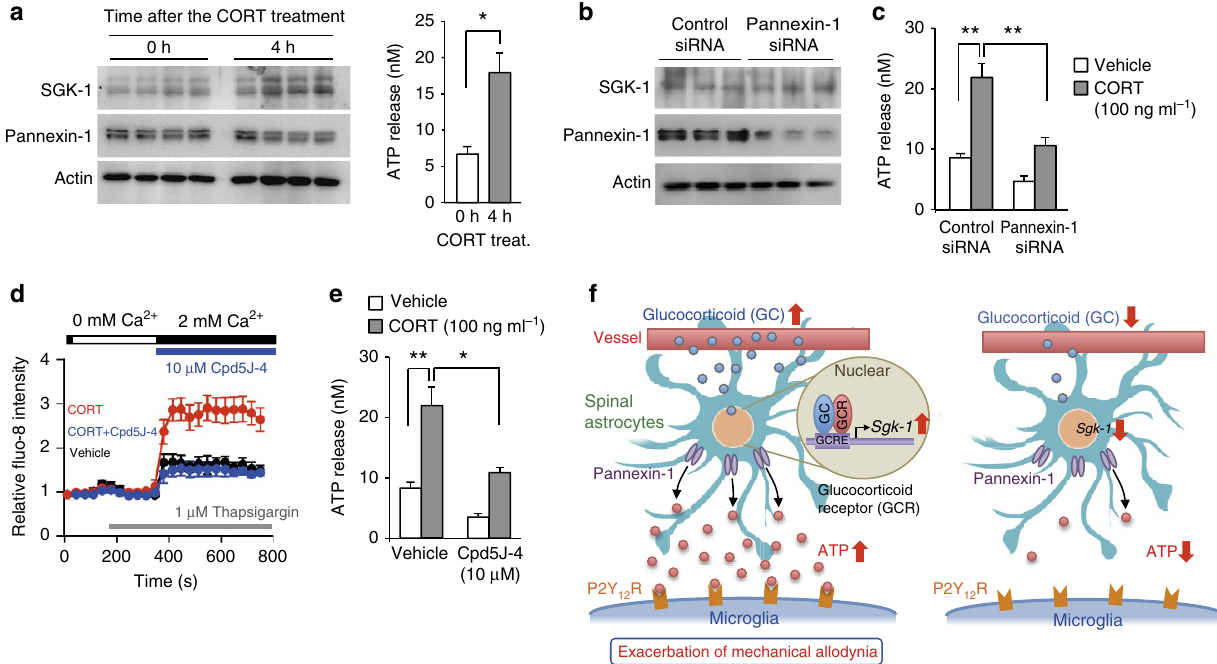
Figure 6 | Induction of SGK-1 by glucocorticoid enhances ATP release from astrocytes via pannexin-1 hemichannels. ( a ) Negligible effects of CORT (100ngml (cid:2) 1 ) on the expression of pannexin-1 in the membrane fraction of astrocytes (left) and release of ATP (right). Cells are treated with 100ngml (cid:2) 1 for 4h. CORT * P o 0.05 significant difference between two groups ( n ¼ 5, means ± s.e.m.; t 8 ¼ (cid:2) 5.445, unpaired t -test, two-sided). Full-size images are presented in Supplementary Fig. 14. ( b ) The downregulation of pannexin-1 in the membrane fraction of astrocytes. Cells are transfected with 150pmol of siRNA against pannexin-1 or scrambled (Control) siRNA. Protein levels were assessed at 72h after transfection. Full-size images are presented in Supplementary Fig. 15. ( c ) Effects of the downregulation of pannexin-1 on the CORT-induced release of ATP from astrocytes (means ± s.e.m.; n ¼ 5 per group). Astrocytic ATP release was assessed 4h after the CORT treatment. ** P o 0.01 significant difference between two groups ( F 3,16 ¼ 19.130, P o 0.001, ANOVA with Tukey–Kramer’s PHT). ( d ) Tracing of the fluo-8 fluorescence intensity during and after Ca 2 þ depletion in astrocytes treated with 100ngml (cid:2) 1 CORT in the presence or absence of 10 m M Cpd5J-4 an Orai1 inhibitor (means ± s.e.m.; n ¼ 8 per groups). Average fluorescence before the measurement is set to 1. ( e ) Effects of Cpd5J-4 on the CORT-induced release of ATP from astrocytes (means ± s.e.m.; n ¼ 5 per group). Cells were treated with 100ngml (cid:2) 1 CORT in the presence or absence of Cpd5J-4 (10 m M) for 4h. ** P o 0.01; * P o 0.05 significant difference between two groups ( F 3,16 ¼ 19.323, P o 0.001, ANOVA with Tukey–Kramer’s PHT). ( f ) Schematic diagram indicating the glucocorticoid-regulated diurnal oscillations in the threshold of mechanical allodynia in PSL mice. Temporal elevations in glucocorticoid levels induce the expression of SGK-1 in spinal astrocytes, thereby enhancing extracellular ATP release through pannexin-1 hemichannels. ATP released from astrocytes binds to P2Y 12 receptors on activated microglia. ATP-stimulated P2Y 12 receptors induce downstream events, which result in a decrease in the threshold of mechanical